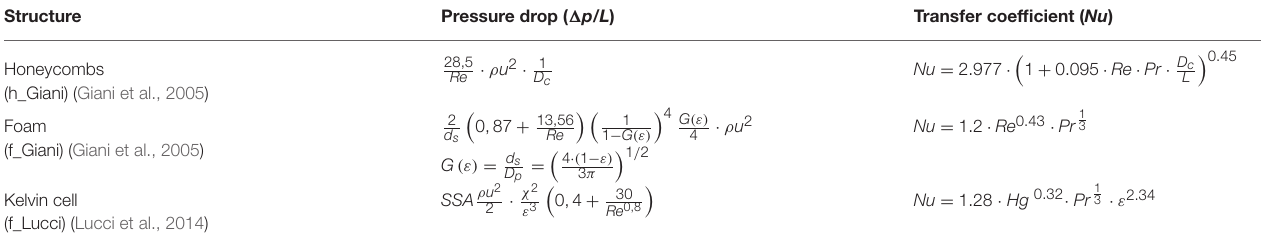
TABLE 1 | Flow resistance and transport correlations used. Structure